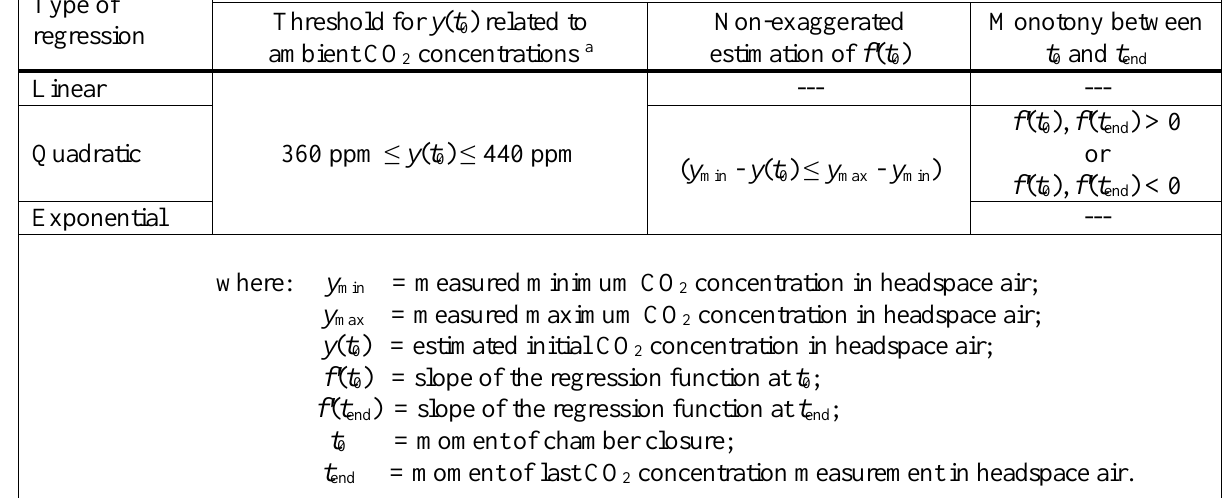
Table 3. Criteria for acceptable regression functions for headspace carbon dioxide (CO 2 ) concentrations. Type of